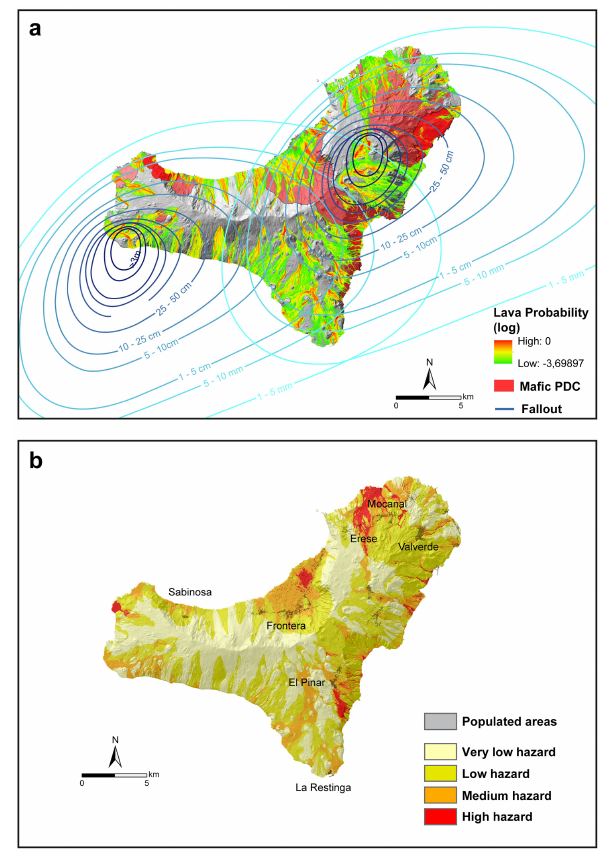
Figure 7. (a) Superposition of the most probable scenarios; (b) qualitative hazard map of El Hierro (zones 1–4) constructed from the combination of the most likely scenarios. This map shows the overall integrated volcanic hazard zones for El Hierro based on lava flows, PDCs and ashfall scenarios. We distinguish four levels of hazard, from very low to high hazard, depending on the number of individual hazards that overlap on each point (pixel) of the map (see text for more